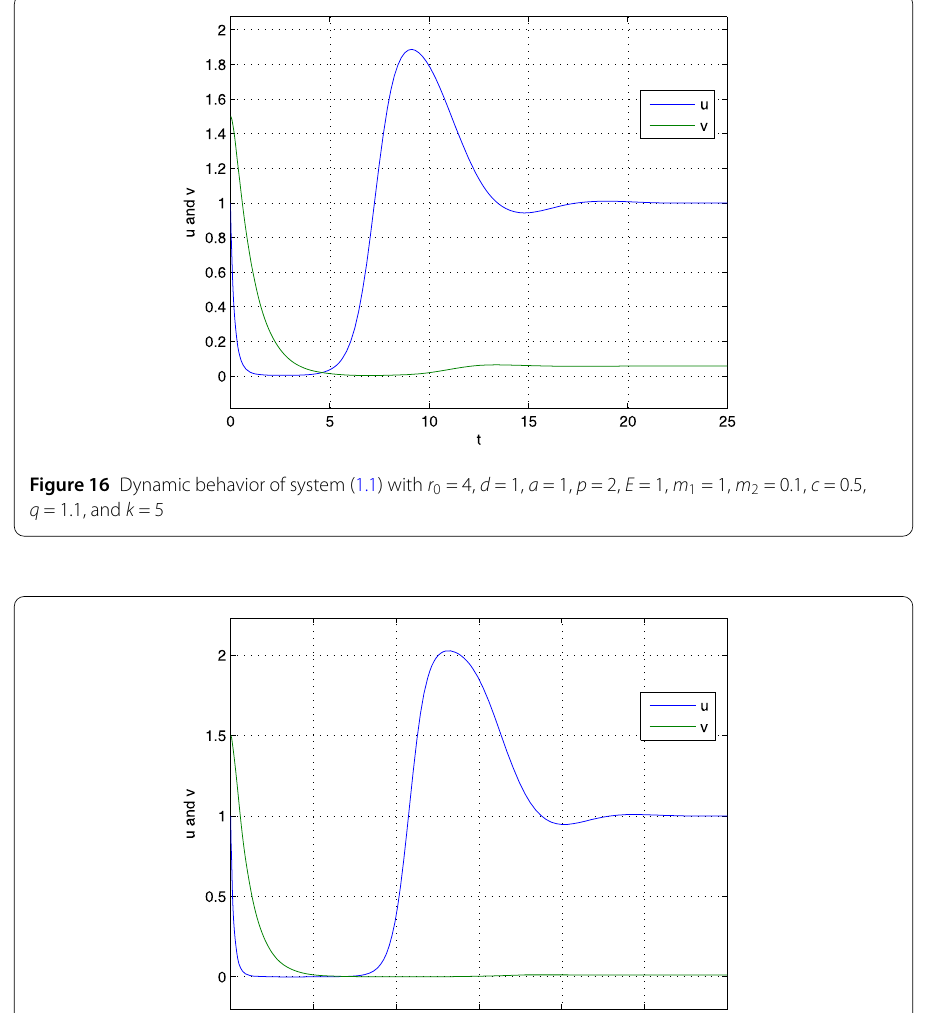
the more time it takes for the number of prey population to stabilize to a constant, the greater the maximum value of prey population, and the smaller the number of predator population (see Figs. 14, 15, 16,